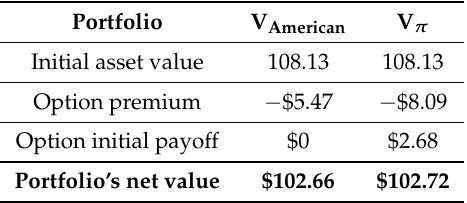
Table 6. Portfolios and their initial net values for the MSFT dataset.